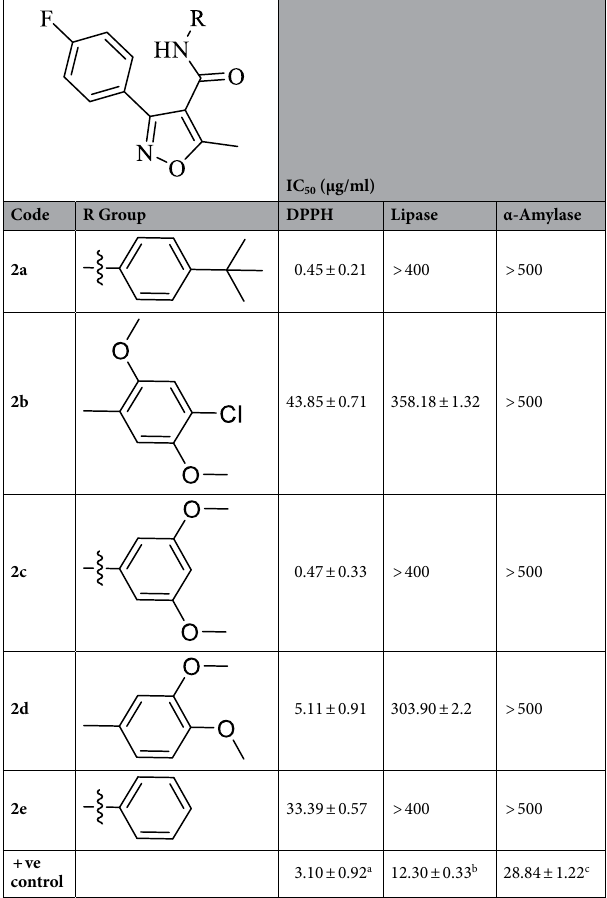
Table 1. IC 50 values (µg/ml) of Fluorophenyl-isoxazole-carboxamide compounds and positive controls on DPPH, α-amylase, and lipase enzyme. P value ≤ 0.05. a Trolox, b Orlistat, c Acarbose.